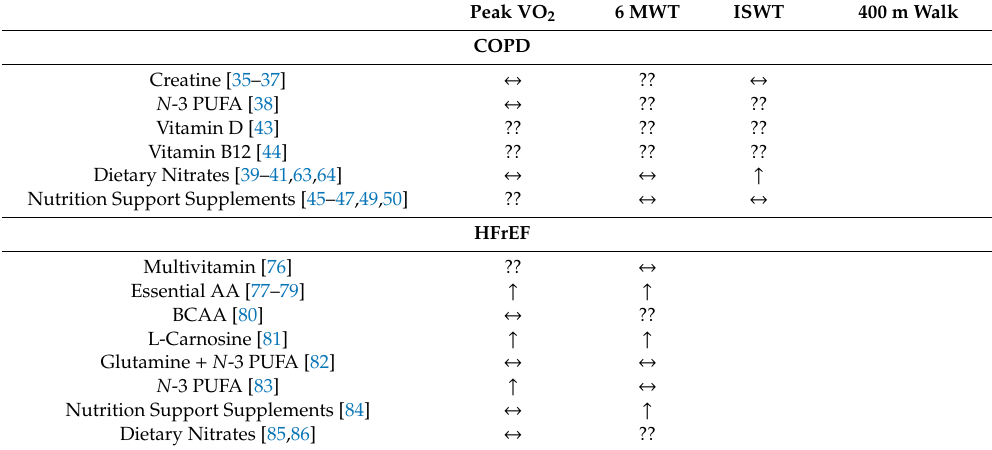
Table 1. A summary of the lifestyle interventions with a nutrition component described in